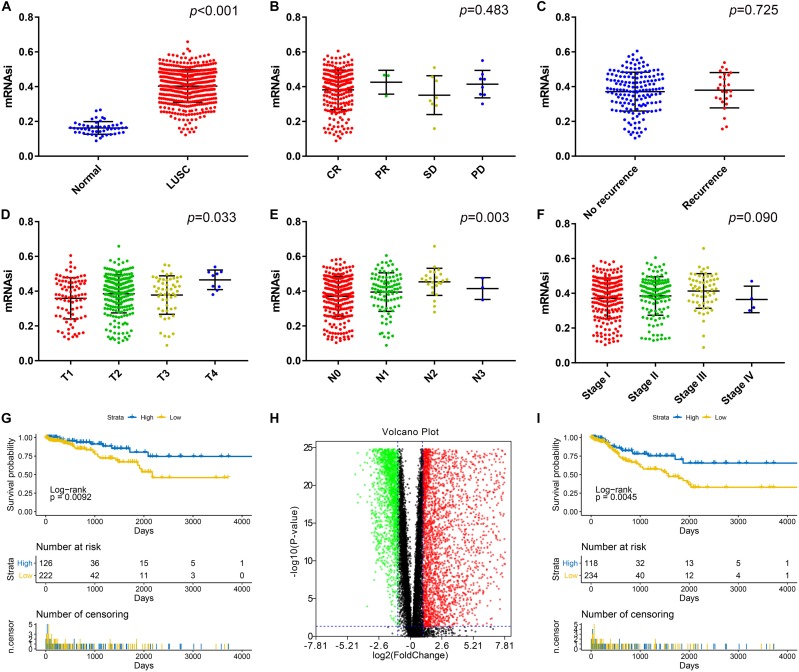
(A) Differences in the mRNAsi between normal (50 samples) and LUSC (487 samples) tissues. (B) Differences in the mRNAsi based on the treatment effect: CR (234 samples), PR (3 samples), SD (8 samples), and PD (8 samples). (C) Differences in the mRNAsi between LUAD patients without (159 samples) and with (26 samples) recurrence after primary treatment without adjuvant therapy. (D) Comparison of the mRNAsi between four different T stages (T1, 86 samples; T2, 221 samples; T3, 52 samples; and T4, 9 samples). (E) Comparison of the mRNAsi between four different N stages (N0, 254 samples; N1, 99 samples; N2, 24 samples; and N3, 3 samples). (F) Comparison of the mRNAsi between four different AJCC stages (stage I; 201 samples, stage II; 132 samples, stage III; 58 samples, and stage IV; 4 samples). (G) Kaplan–Meier survival curves show that the low mRNAsi group had a better OS rate than the high mRNAsi group. (H) Volcano map of DEGs: green indicates downregulated genes, and red indicates upregulated genes. (I) Kaplan–Meier curves show that the low mRNAsi group had a better PFS rate than the high mRNAsi group. LUSC, lung squamous cell carcinoma; mRNAsi, mRNA expression-based stemness index; AJCC, American Joint Committee on Cancer; OS, overall survival; PFS, progression-free survival. CR, complete response, PR, partial response, SD, stable disease, PD, progressive disease.